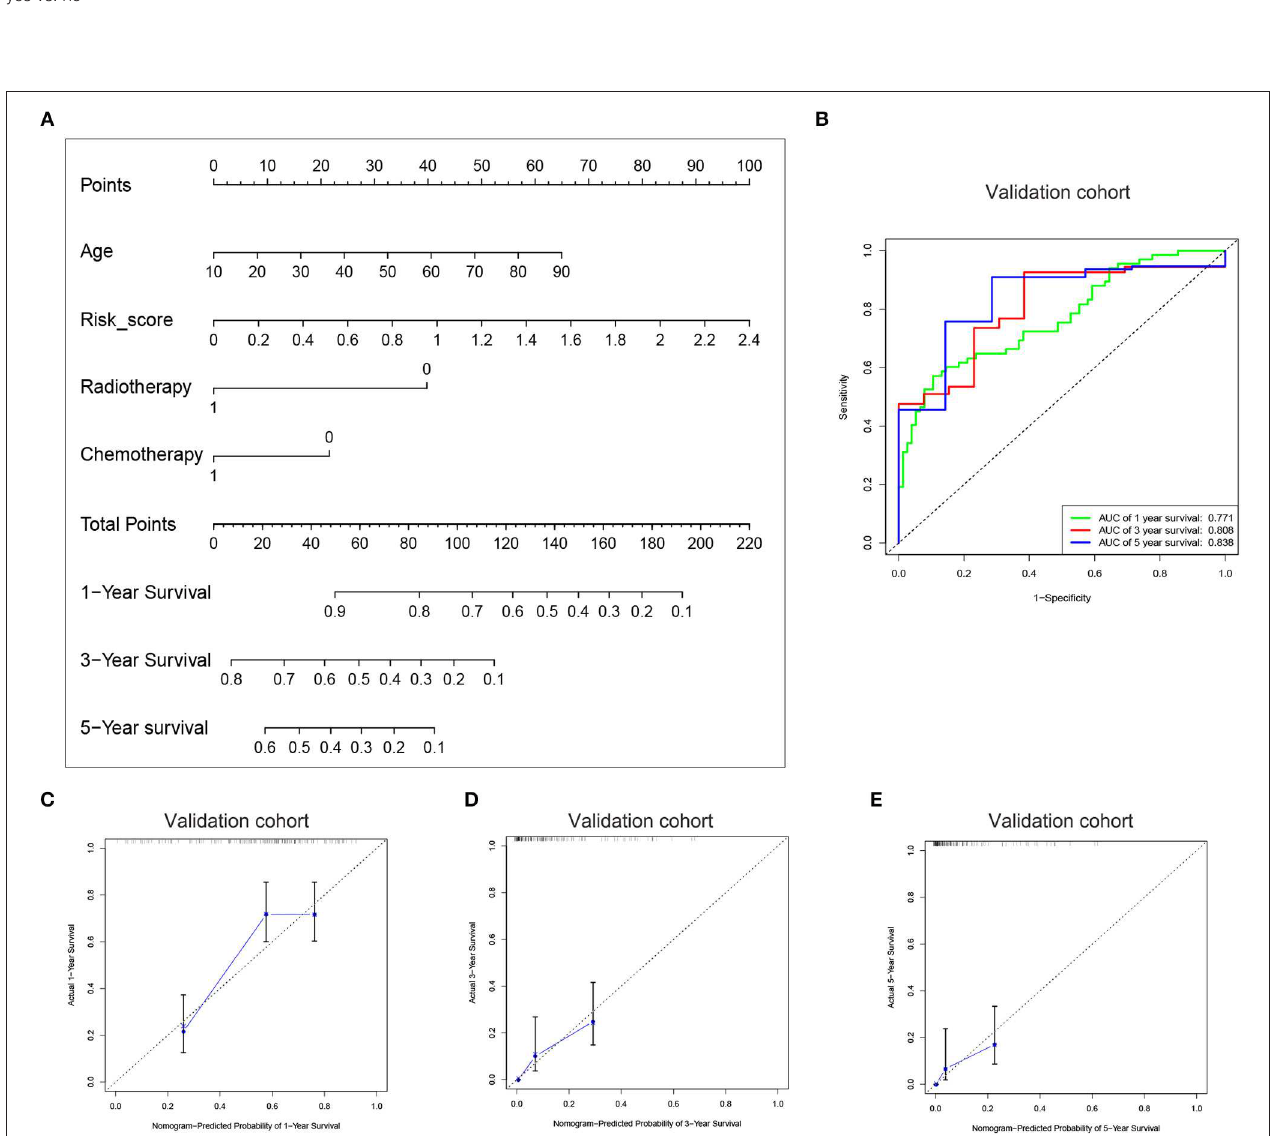
FIGURE 5 | Construction of the nomogram based on the risk signature with five-gene. (A) The nomogram was constructed for predicting 1, 3, 5-year survival rate of GBM patients. (B) ROC curve was used to evaluate the efficiency of the clinical predictive model. (C–E) The calibration curves for predicting patient survival at 1, 3, and 5 years in the validation